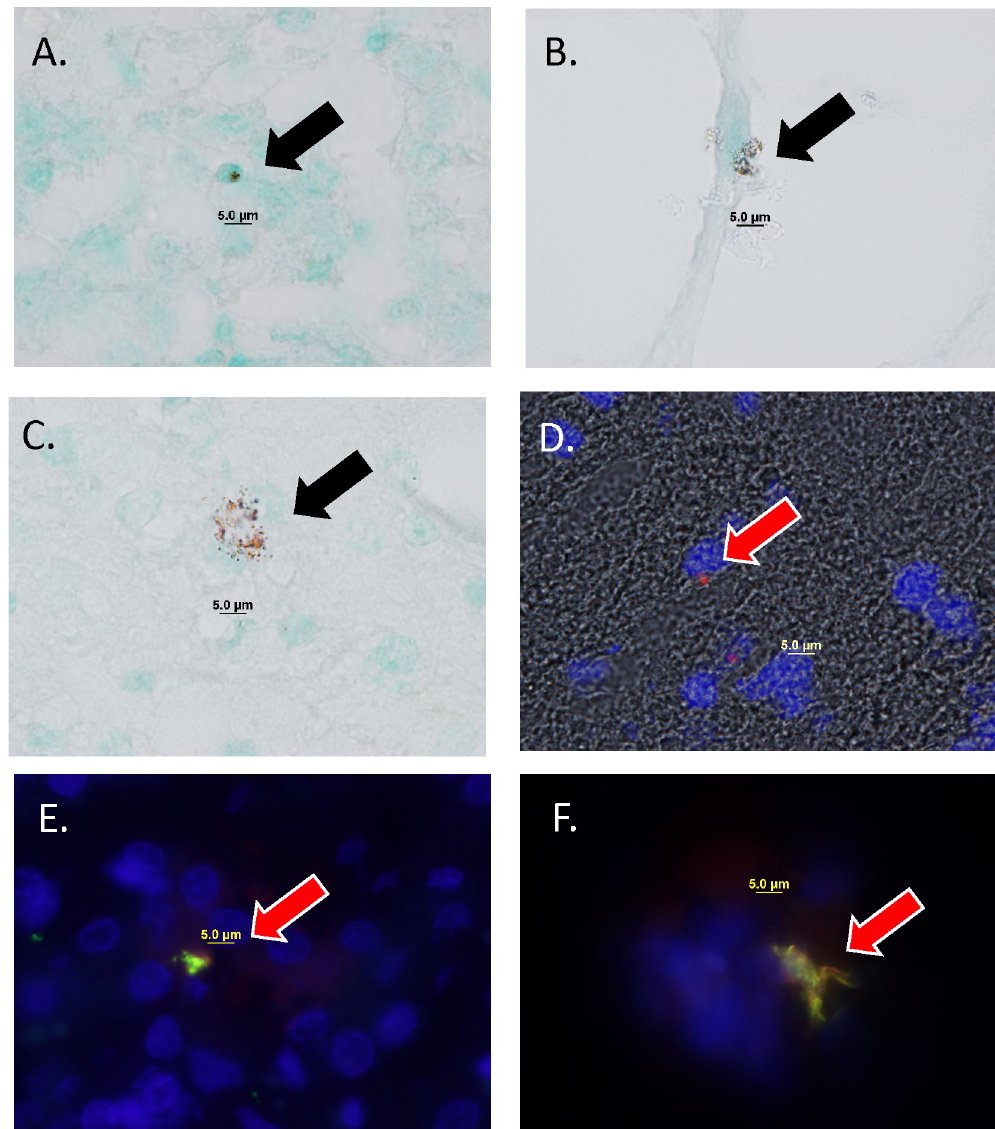
Fig 1. Immunohistochemistry (panels A-C) and immunofluorescence (panel D) images of green fluorescent protein- immunoreactive structures in fetal tissues 5–7 days post-inoculation of GFP-expressing S . aureus into the maternal bloodstream. Panel A, iGFP in fetal liver (fetus 6A). Panel B, iGFP in fetal cerebral cortex (fetus 6B). Panel C, iGFP in fetal cerebral cortex (fetus 20B). Panel D, merged image (brightfield, DAPI, red fluorescence) of immunofluorescence detection of GFP protein in fetal cerebral cortex (fetus 25B). In all panels images were recorded using oil immersion with a 100x microscope objective. Panels E and F, merged image (red anti- S aureus , green anti-GFP, blue DAPI) fetal liver (fetuses 6A and 6B,